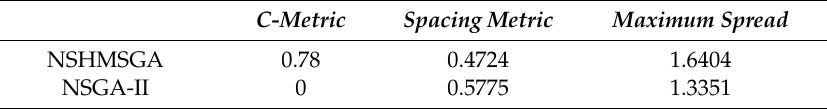
Table 7. Quantitative evaluation index values for the two algorithms.